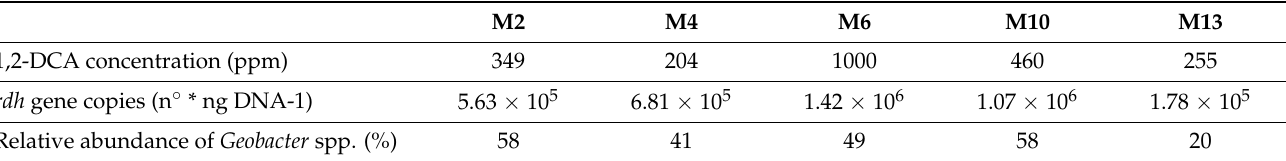
Table 1. Comparison between 1,2-DCA concentration values (ppm), rdh gene copy number and relative abundance (% of the total species) of Geobacter spp. in different monitoring wells of the pilot test